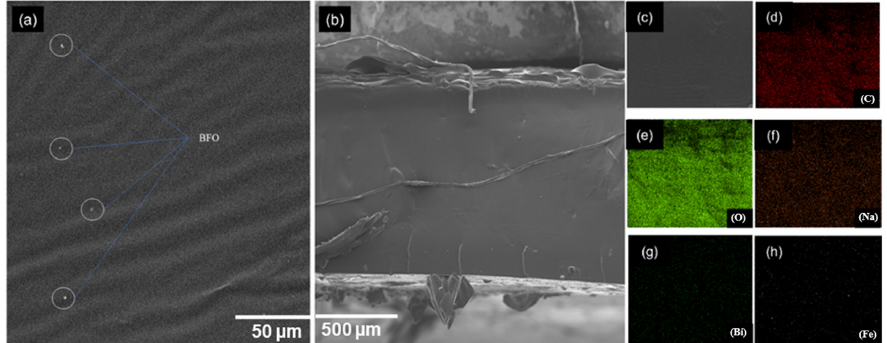
Figure 4. Electron backscattering SEM image ( a ) and cross-section OCMC/BFO film ( b ), mapping distribution of C, O, Na, Bi, Fe within the layer of CMC OPEFB /BiFeO 3 film produced ( c – h ).